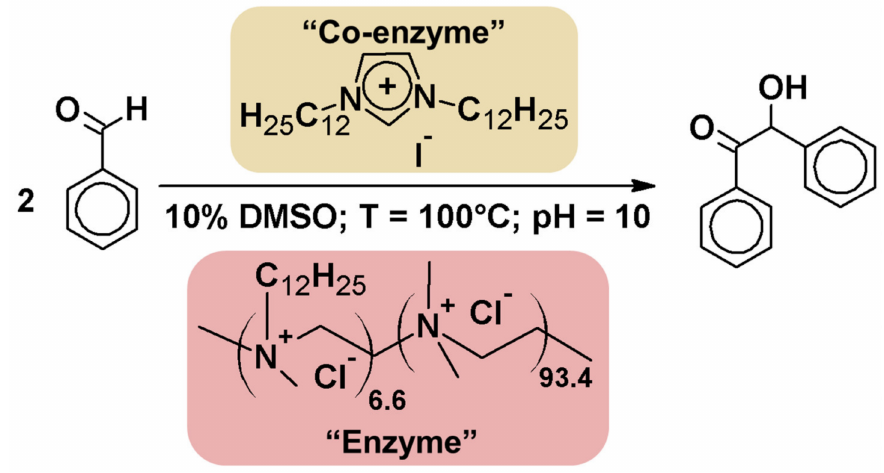
Figure 5. Benzoin condensation catalyzed by an artificial enzyme with imidazolium as coenzyme mimics. T, Temperature.